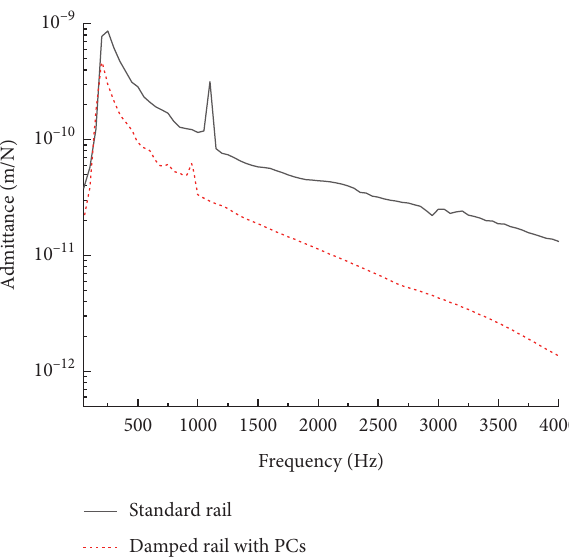
Figure 10: Vertical displacement admittances of standard rail and damped rail with PCs at response